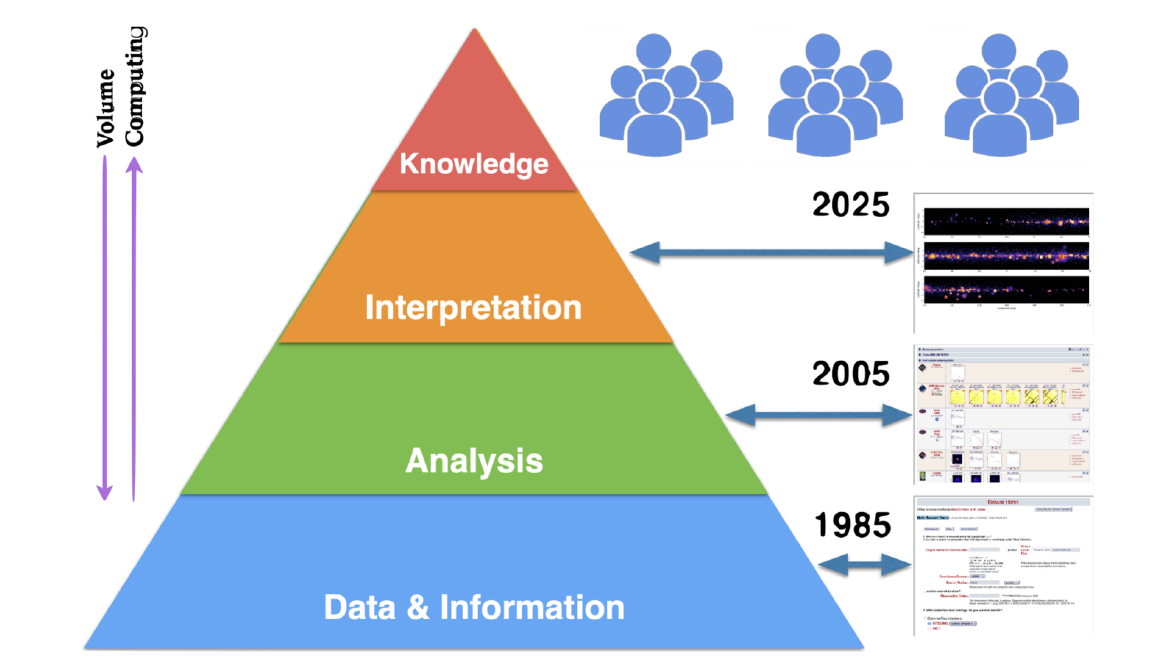
Figure 2. Diagram illustrating how the increase of computational processing of the data, to high-level science products, can induce increased accessibility to knowledge. Adapted from a figure by Roland Walter presented at the 2017 UN-Italy Workshop on the Open Universe